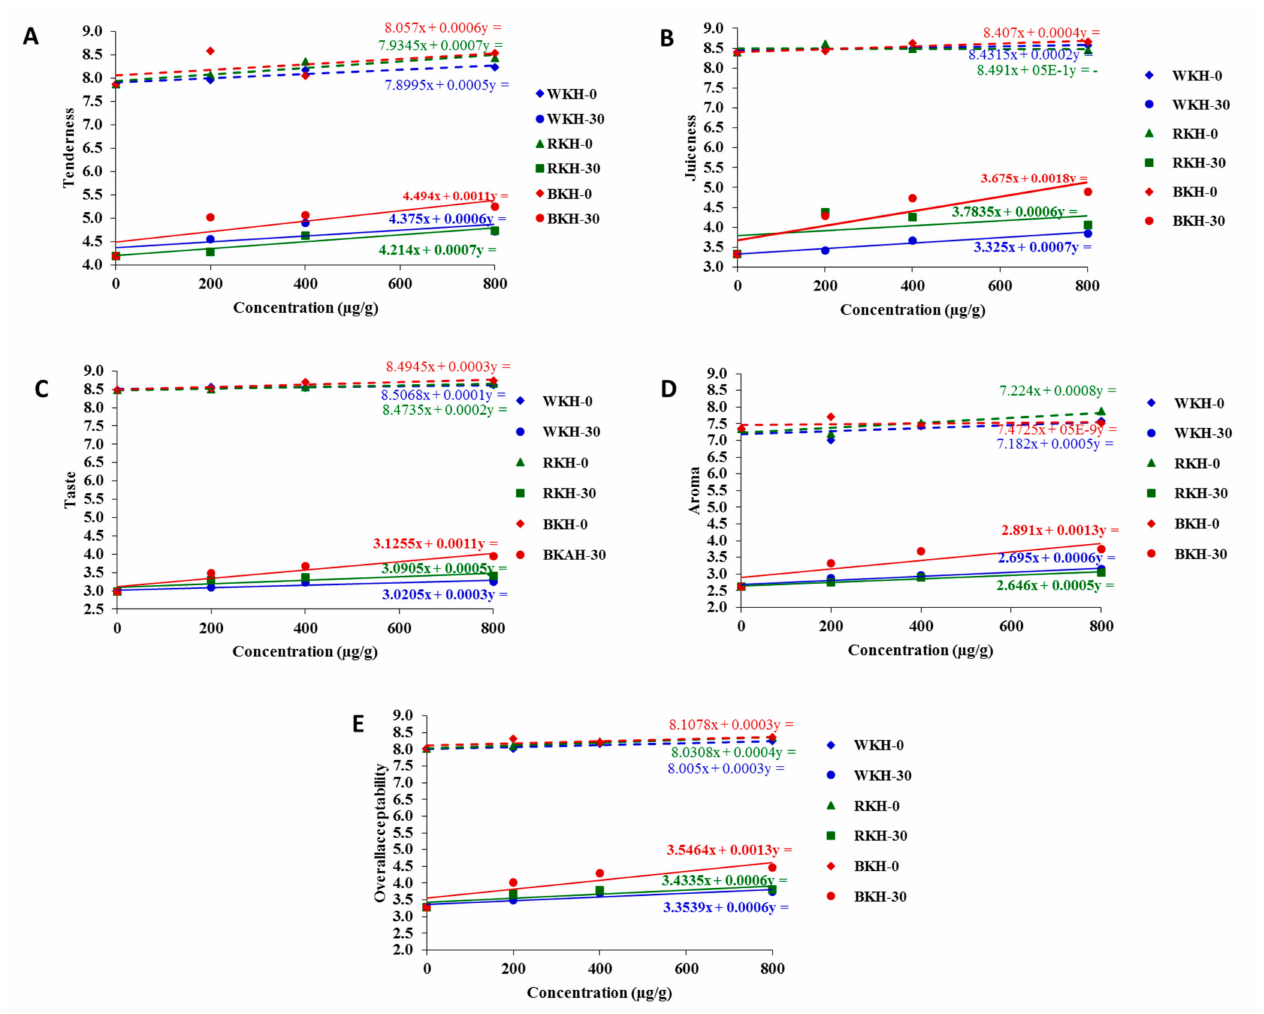
Figure 7. Expected changes in sensory properties; ( A ) Tenderness, ( B ) Juiciness, ( C ) Taste, ( D ) Aroma, ( E ) allover accept- ability of cooked chicken meat supplemented with BKH, RKH, and WKH with increasing concentration or storage period expressed by trendline regression curves for results prediction. Table 9. Total bacterial count (TBC) and psychrophilic bacterial count (PBC) of raw chicken meat, at 0 and 30 days cold storage at 4 ◦ C, as supplemented with black, red, and white kidney bean protein hydrolysate (BKH, RKH, and WKH) obtained by 30 min Alcalase hydrolysis.